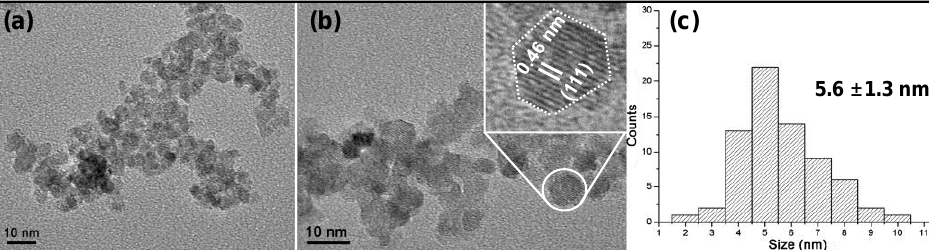
Figure 6. TEM images with ( a ) low magnification and ( b ) high magnification. The high-resolution TEM image of ( b ) shows the lattice spacing of s -CO 3 O 4 NPs. ( c ) Size histogram of the s-Co 3 O 4 NPs based on the TEM analysis.